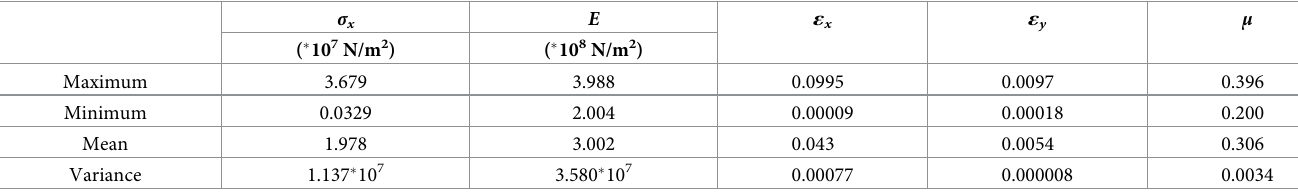
Fig 4. Comparison of EPR results (R 2 ) for different values of λ to L2RM (dataset 1). (a) m = 3, (b) m = 4, (c) m = 5, (d) m = 6, (e) m = 7 and (f) m = 8. https://doi.org/10.1371/journal.pone.0282029.g004 Figs 7 and 8 compare the EPR results (R 2 ) of different values in λ with L1RM and L2RM, respectively. Since the effect of the error was larger, the regression results (R 2 ) were volatile. Moreover, the change of λ in L1RM and L2RM was irregular. The rules of finding the appro- priate λ are still the same, i.e., the R 2 premise is large (closer to 1); λ is also as large as possible. Table 2. Statistics of the parameters and variables in dataset